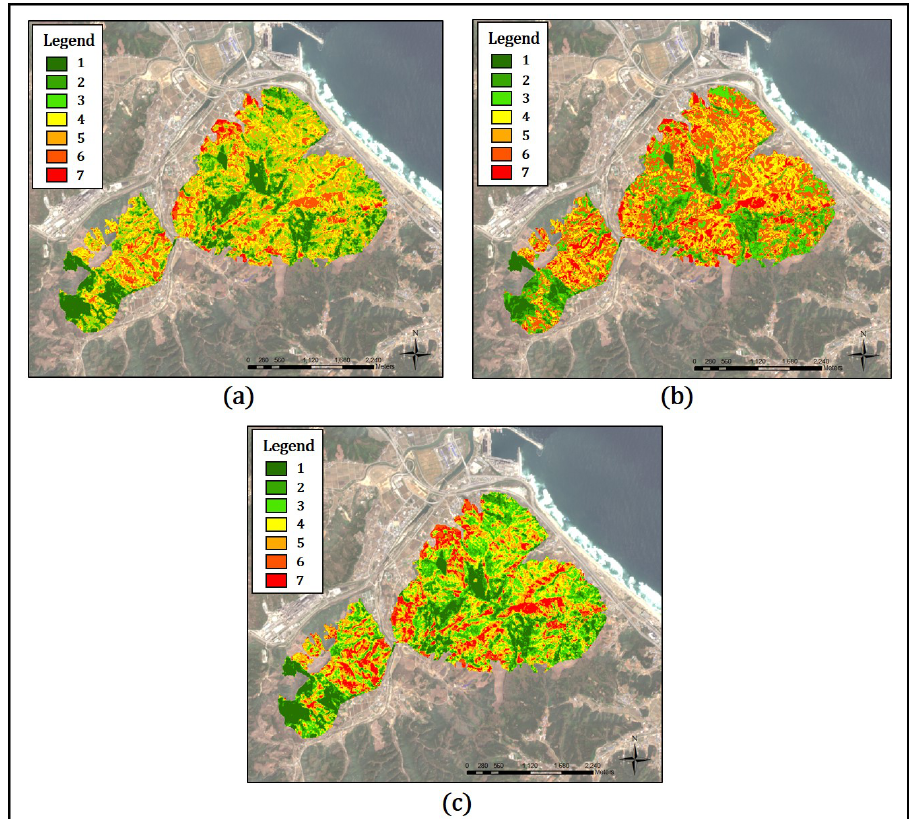
Figure 7. Cluster analysis of vegetation indices: ( a ) Normalized Difference Vegetation Index (NDVI), ( b ) Enhanced Vegetation Index (EVI), and ( c ) Soil-Adjustment Vegetation Index